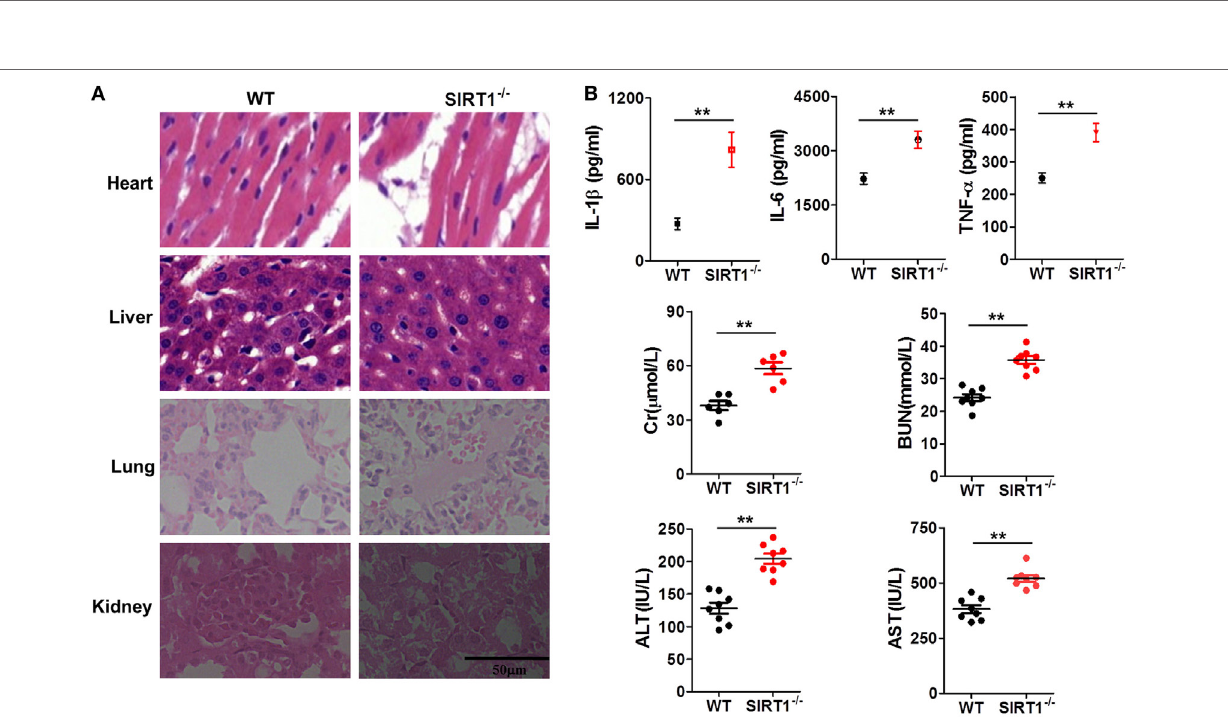
FigUre 3 | Lipopolysaccharide (LPS)-induced inflammation and organ injury were more severe in sirt1 − / − mice than in wild-type (WT) mice. (a) Hematoxylin and eosin (H&E) staining of heart, liver, lung, and kidney tissues from sirt1 − / − and WT mice after peritoneal injection of LPS. Sections were examined and photographed under a microscope. (b) Blood was collected from the left ventricle and serum IL-1 β , IL-6, and TNF- α levels were examined and serum creatinine (Cr), blood urea nitrogen (BUN), alanine aminotransferase (ALT), and aspartate transaminase (AST) levels were measured using commercial ELISA kits.** p < 0.01 compared with WT mice; n = 6. Scale bar = 50